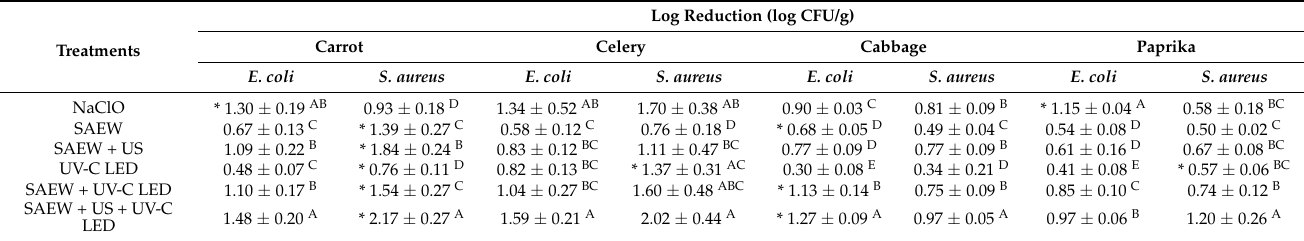
Table 3. Reduction populations of pathogenic E. coli (cocktail of EPEC, ETEC, and E. coli O157:H7) and S. aureus (SEA) in various fresh-cut vegetables by disinfection treatments.